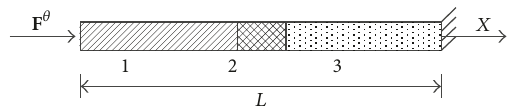
Figure 1: A uniform thermoelastic configuration with one end fixed and the other end subjected to a rectangular impulse heat load.